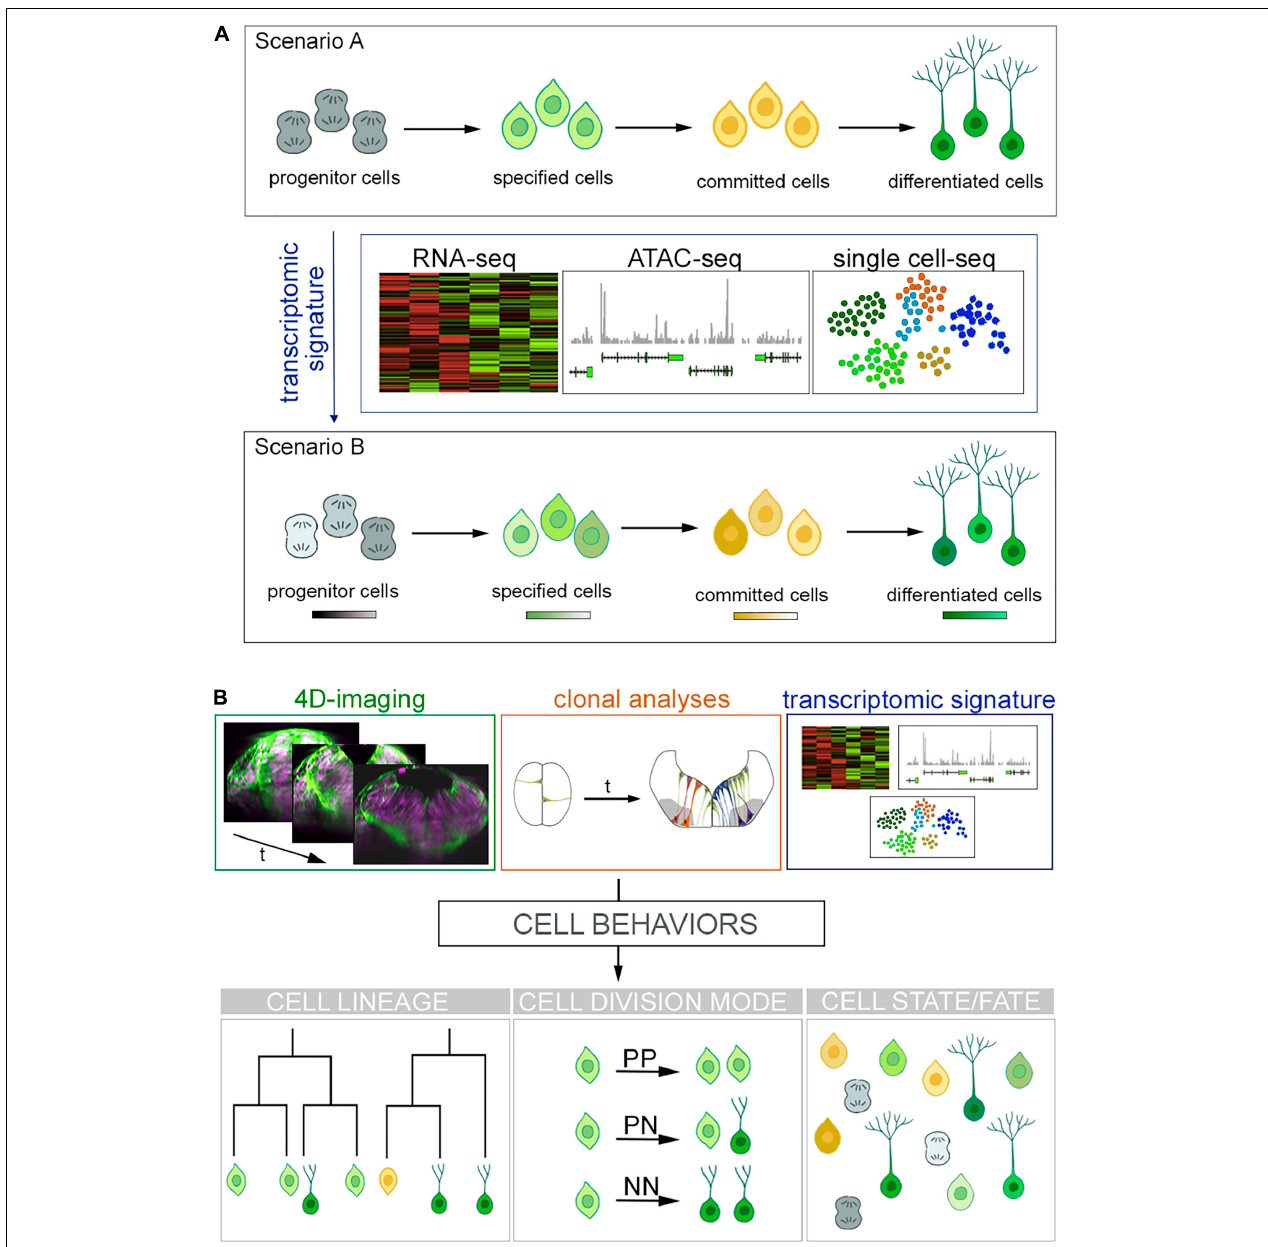
FIGURE 1 | Cell fates vs. cell states and new approaches for cell lineage reconstruction. (A) Overview of the current scenarios for cells progressing toward differentiation. Scenario A shows progenitor cells transitioning toward specification and commitment to finally differentiate. New high-throughput sequencing technologies (RNA-seq, ATAC-seq, and single cell sequencing) produce large volumes of data providing transcriptomic signatures. This unveils the emergence of different cell states within a cell fate depicted as color hues in Scenario B. (B) Future challenges to comprehend how cells acquire their fate. Next generation tools might blend big data provided by (i) 4D imaging that informs us about cell hierarchies and behaviors (see transverse views of zebrafish hindbrain over time; cell nuclei are in magenta and plasma membranes in green), (ii) clonal analyses, which informs about tissue growth; and (iii) transcriptomic signatures telling us about GRN in order to fill the gap between genetic determinism, cell behavior and cell fate while keeping the morphological context. The best scenario would be to blend such amount information in order to understand cell behaviors and to generate full cell